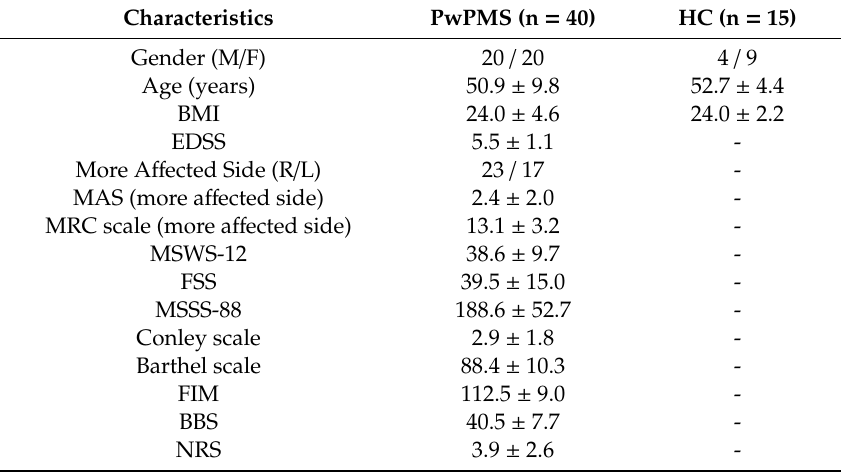
Table 1. Data demographics of the subjects and clinical assessments. No significant di ff erence was found in gender ( p = 0.3381), age ( p = 0.4971) nor in body mass index (BMI, p = 0.9448) between groups. Data are shown in mean ± standard deviation format. PwPMS: patients with progressive multiple sclerosis; HCs: healthy controls. MAS: Modified Ashworth Scale; MRC Scale: Medical Research Council Scale; MSWS-12: 12-Item MS Walking Scale; FSS: Fatigue Severity Scale; MSSS-88: MS Spasticity Scale-88; FIM: Functional Independence Measure; BBS: Berg Balance Scale; NRS: Numeric Rating Scale of